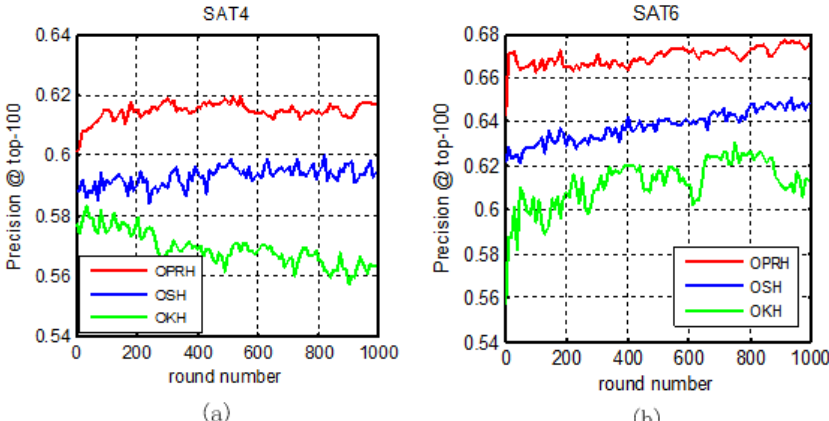
Figure 4. Comparison of average precision at each round of the online hashing methods on: ( a ) SAT-4 dataset; and ( b ) SAT-6 dataset (64-bits).